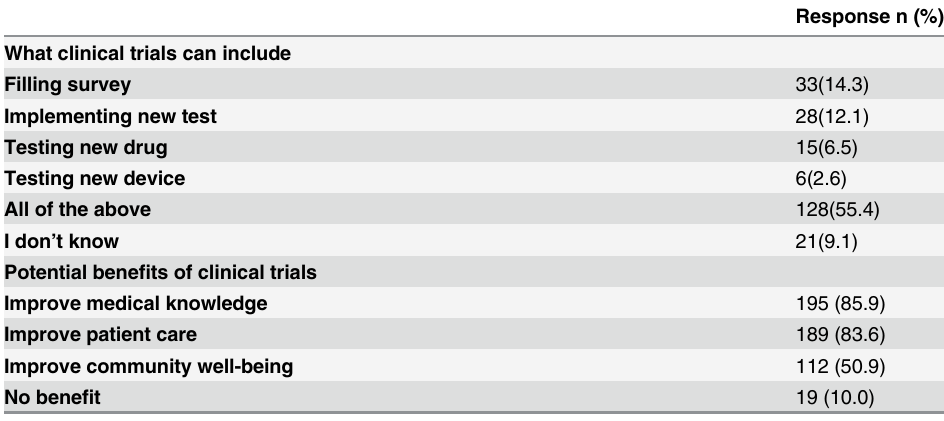
Table 2. Knowledge of respondents about clinical trials.